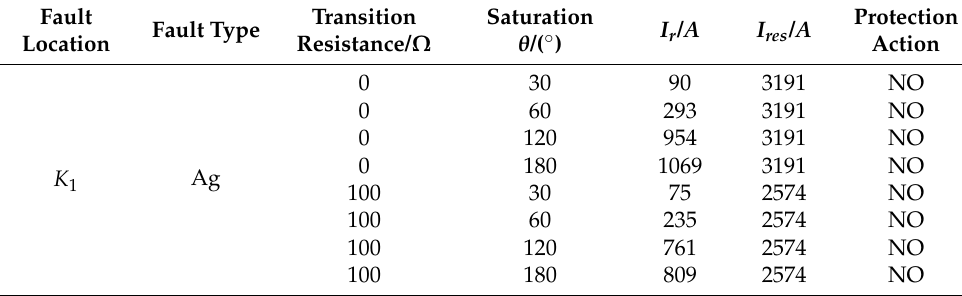
Table 3. Grounding external fault occurs.